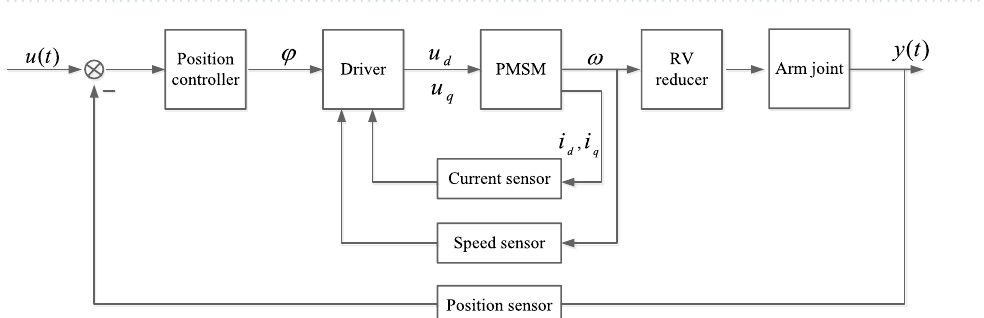
Figure 9. The process of experiment.